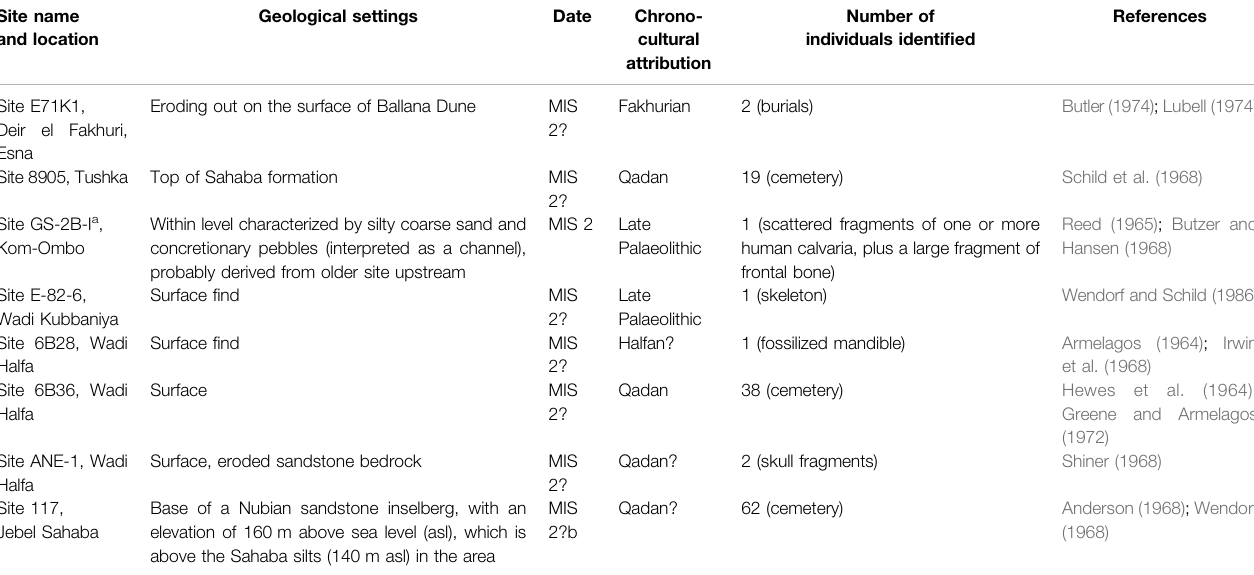
TABLE 4 | List of human fossils dated to MIS 2 from the Nile